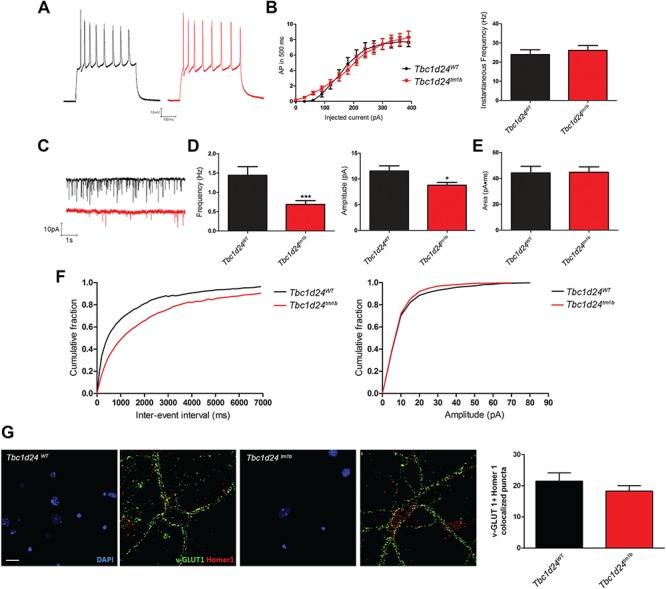
Genetic disruption of Tbc1d24 expression results in decreased mEPSC frequency with no effect on excitatory synapse number in hippocampal primary neurons. (A) Representative current-clamp recordings of spike trains evoked by somatic current injection of 300 pA for 500 ms from hippocampal WT Tbc1d24WT (black) and mutant Tbc1d24tm1b (red) mice. (B) AP in 500 ms (or mean firing frequency in Hz) versus injected current (pA; left) and averaged instantaneous frequency at 300 pA (right) (N = 31 neurons from 4 independent preparations). (C) Representative traces of mEPSCs recorded at −70 mV in 14 DIV hippocampal neurons from Tbc1d24WT (black) and Tbc1d24tm1b (red) mice. (D) Histograms showing average peak frequency and amplitude of mEPSCs. (E) Average amplitude of mEPSCs calculated as peak area. (F) Cumulative plot of peak frequency (left) and amplitude (right) showing a selective defect in the peak frequency (N = 25 and 27 neurons from Tbc1d24WT and Tbc1d24tm1b mice respectively from 4 independent preparations). (G) Representative images of Tbc1d24WT and Tbc1d24tm1b hippocampal culture immunolabelled with the glutamatergic presynaptic and postsynaptic markers v-GLUT1 and Homer1. Nuclei are stained with DAPI. Number of v-GLUT1 and Homer1 positive puncta are automatically counted and normalized to the number of cells in the field (N = 28–24 fields per experimental condition from 3 independent preparations). Scale bar: 20 µM. All data are expressed as the mean ± SEM. (B, D, E, G) *P < 0.05;
***P < 0.001; unpaired t-test.